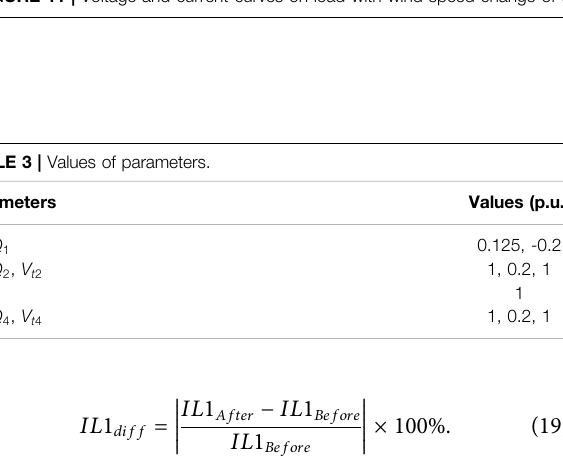
FIGURE 11 | Voltage and current curves on load with wind speed change of the typical APME model.